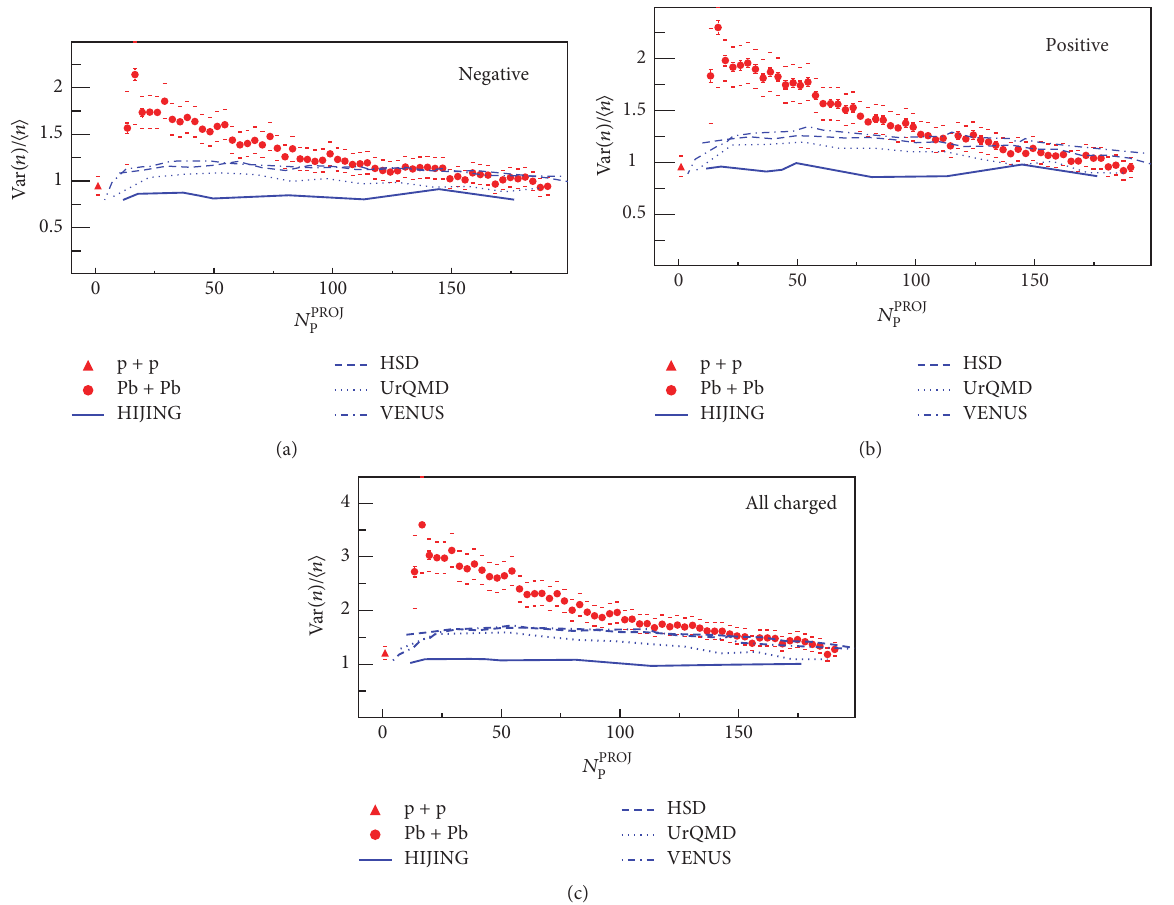
Figure 2: The scaled variance of the multiplicity distribution for negatively (a), positively (b), and total (c) charged particles as a function of centrality in terms of number of projectile participants in Pb + Pb collisions at 158AGeV [43]. The experimental results are compared with model simulations in the NA49 acceptance (HSD and UrQMD predictions were taken from [44]). The statistical errors are smaller than the symbols (except for the most peripheral points). The horizontal bars indicate the systematic